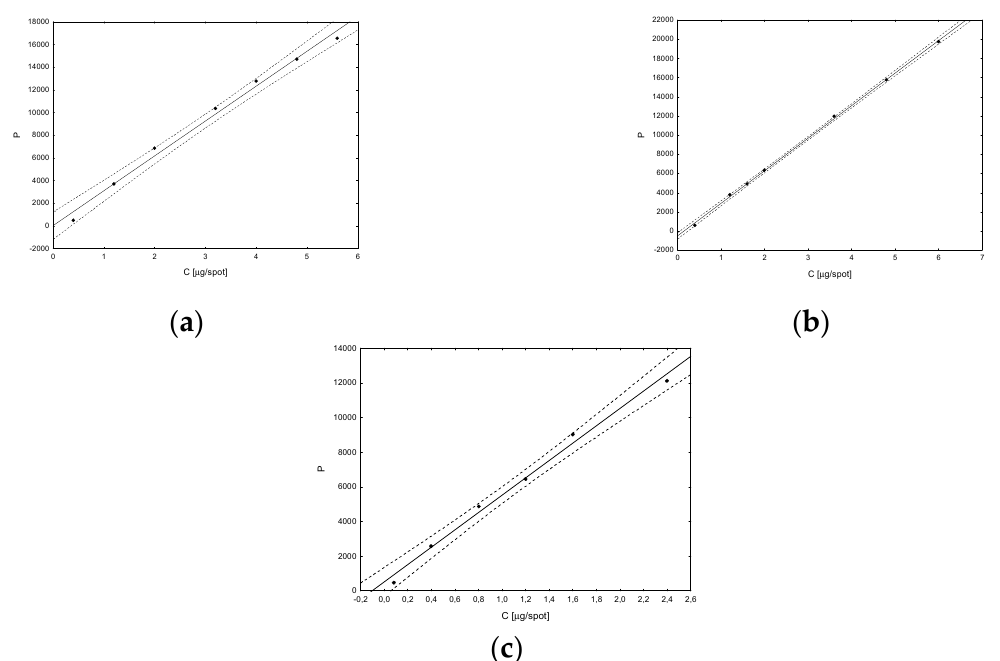
Figure 4. Calibration curves (peak area vs concentration; ±0.95% conf. int.) for vitamin standard solutions: D 2 ( a ), D 3 ( b ) and K 2 ( c ).